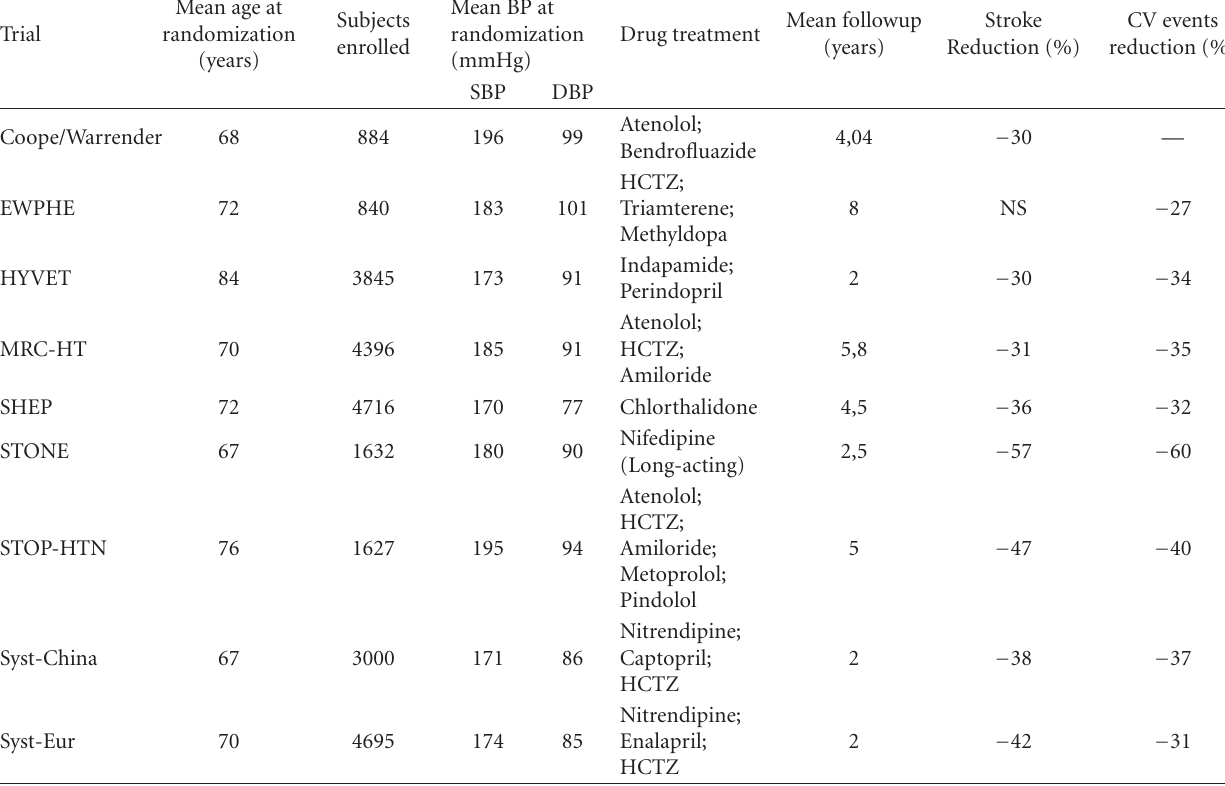
Mean followup Stroke CV events (years) Reduction (%) reduction (%)